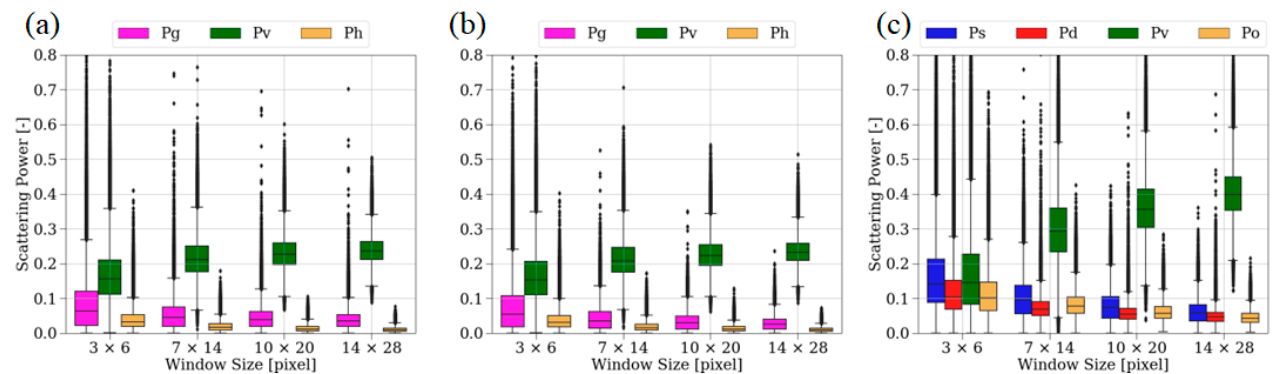
Figure 10. Box and whisker plots of the scattering power components using the forest pixels of the reference data: ( a ) proposed method with HH/HV data, ( b ) proposed method with VV/VH data, and ( c ) 6SD method with POLSAR data. The whiskers extend to 1.5 times the interquartile range. In ( c ), P o is the summation of the helix scattering, oriented dipole scattering, and compound dipole scattering powers.